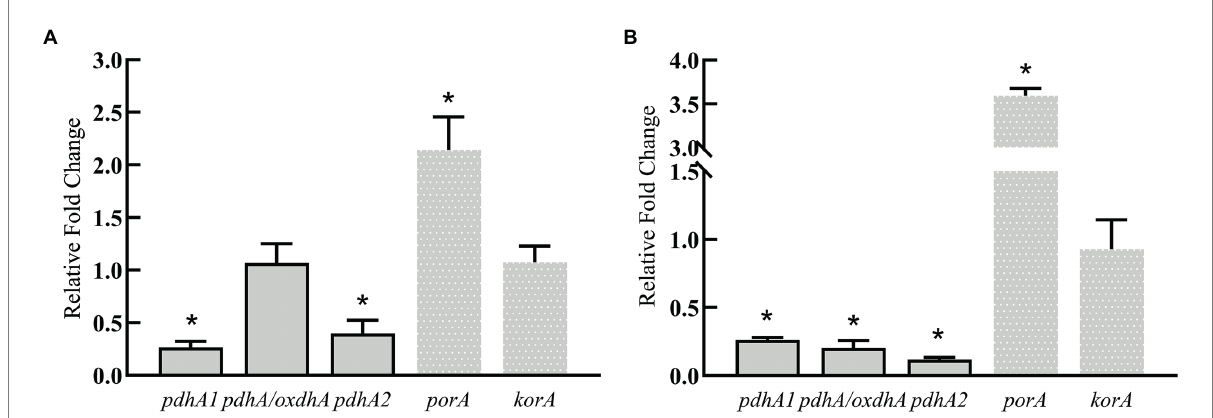
FIGURE 6 The relative expression levels of key genes ( pdhA / oxdhA , pdhA1 , pdhA2 , korA , porA ) in two pathways related to 3 HV synthesis in strain ATCC 33500 under short-term (A) and long-term (B) exposure to the silkworm excrement. All the data are presented as means of duplicates with their standard errors [*significant differences ( p < 0.05)].